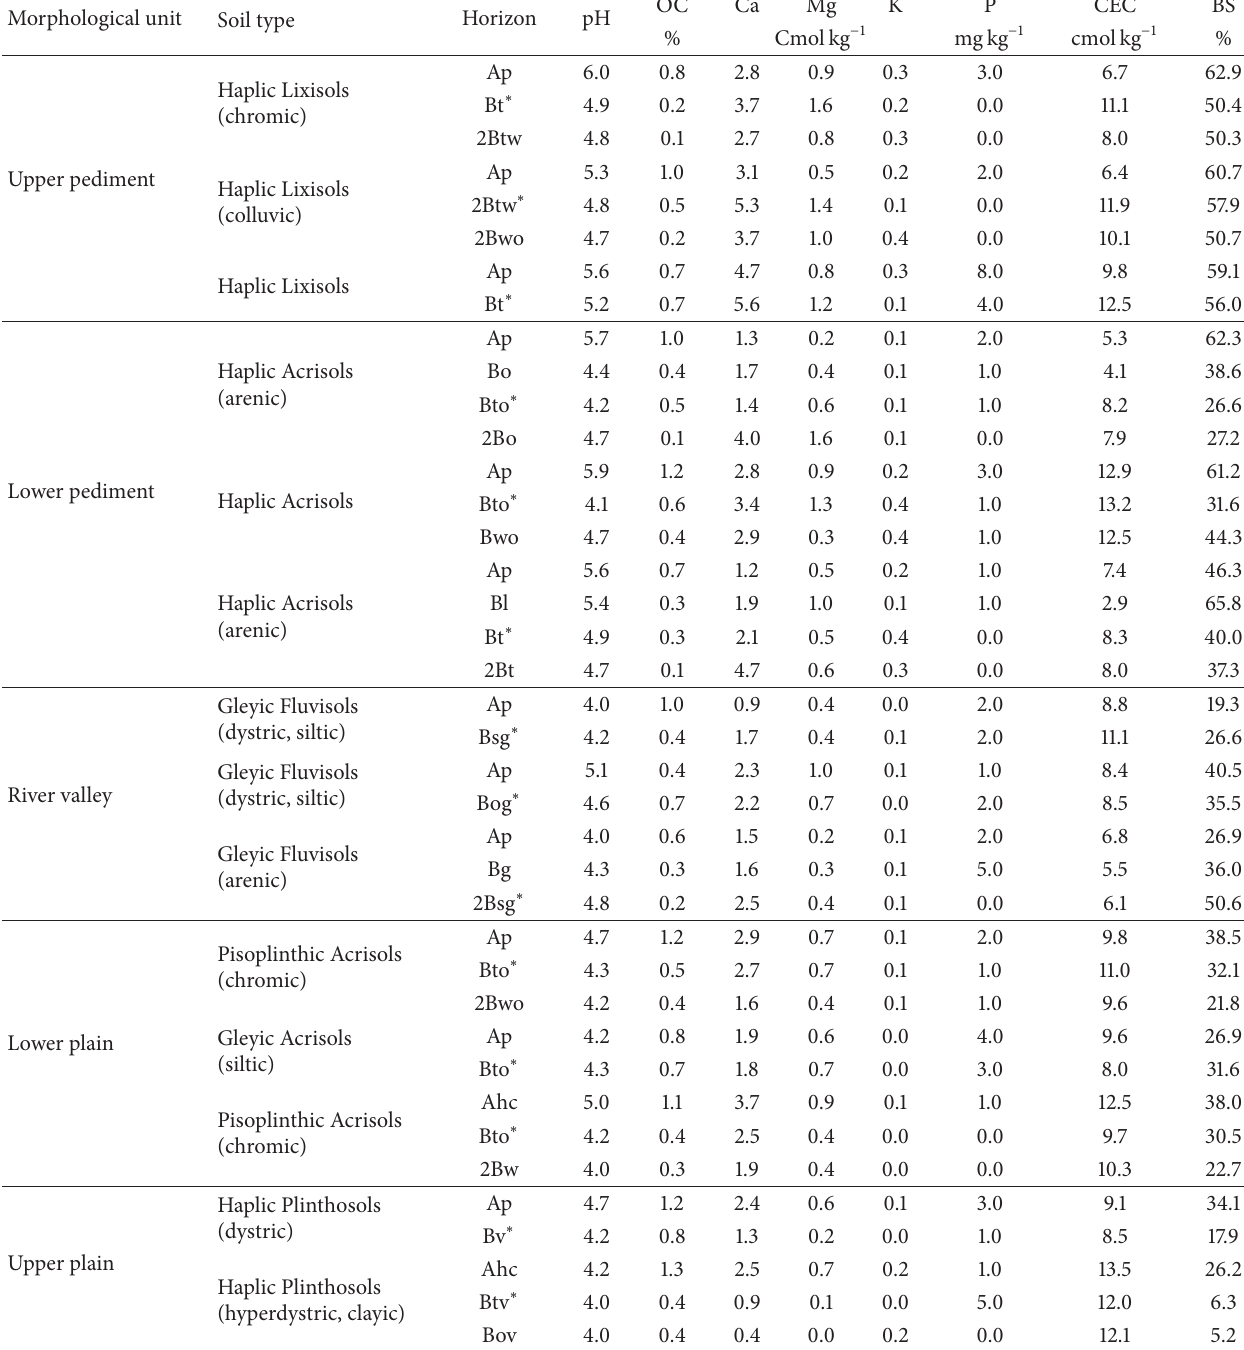
Table 2: Chemical soil characteristics of the soils of the study